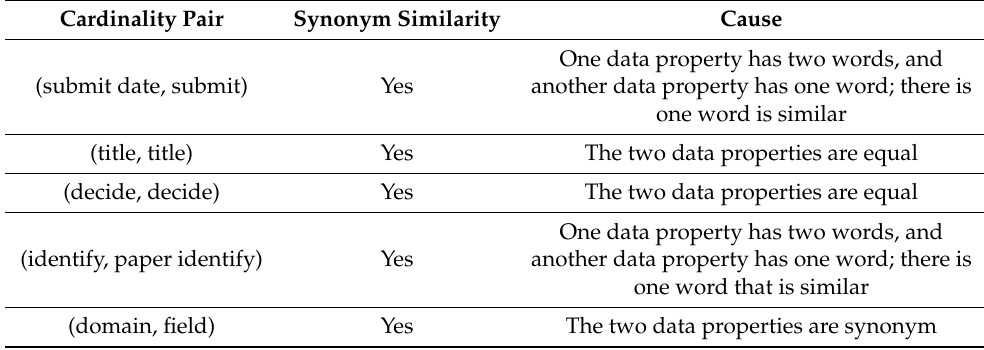
Table 7. The positive results of comparison